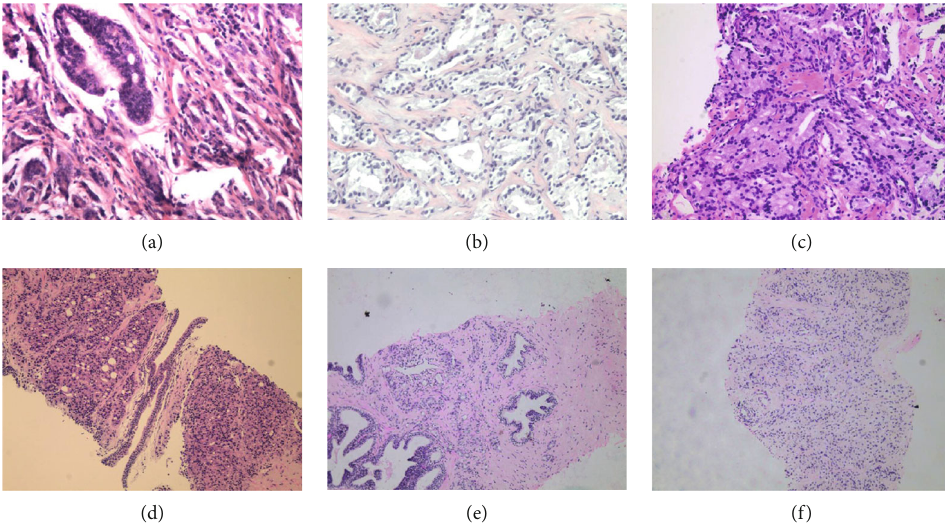
Figure 2: Typical images seen in a pathological examination. (a) A subject with a Gleason score of 5, (b) a subject with a Gleason score of 6, (c) a subject with a Gleason score of 7, (d) a subject with a Gleason score of 8, (e) a subject with a Gleason score of 9, and (f) a subject with a Gleason score of